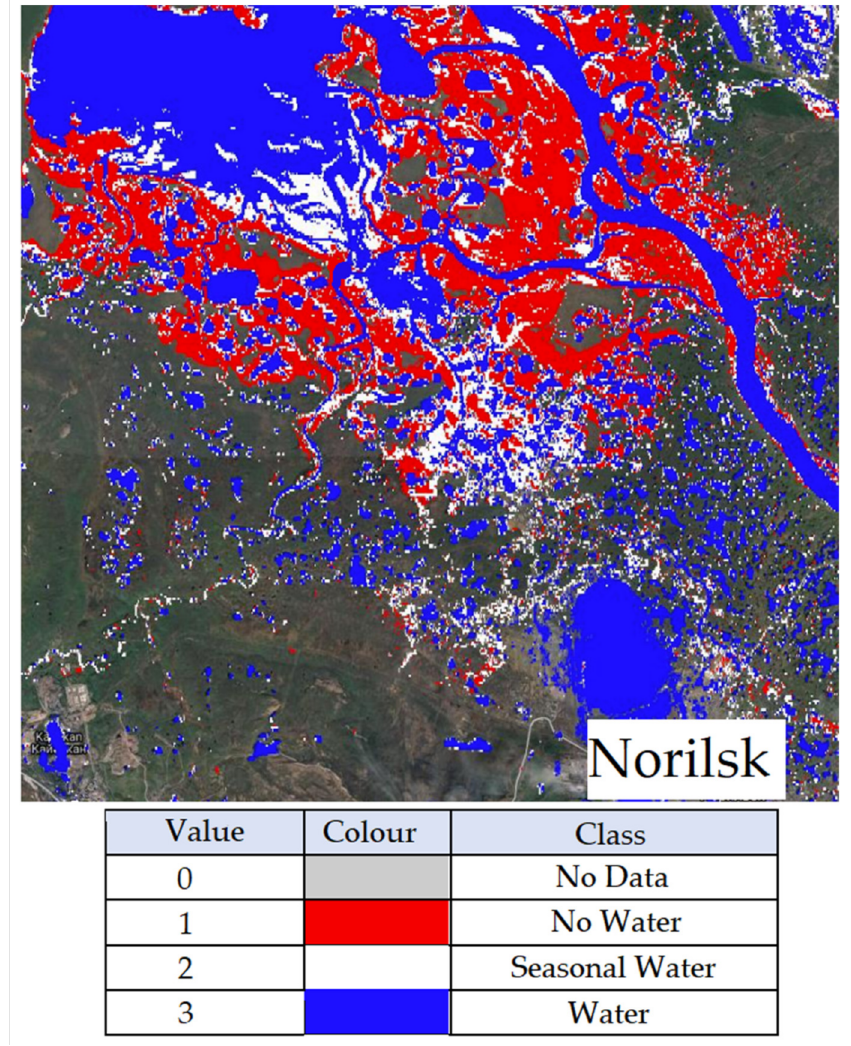
Figure 9. Yearly Water Classification History in Norilsk